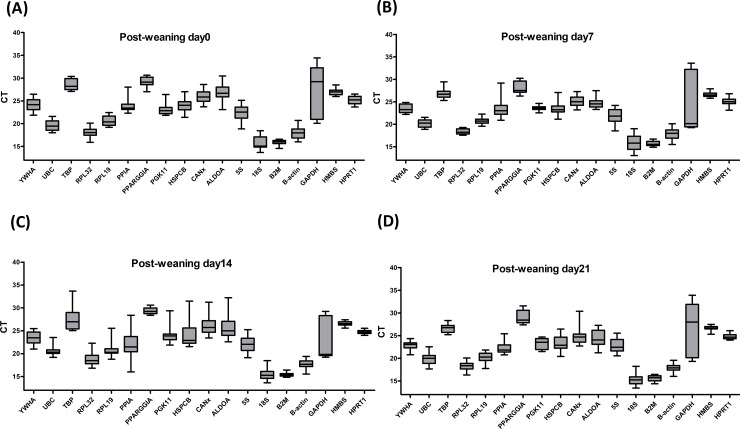
Distribution of the CT values of the reference genes at different growth stages of the gastrointestinal tract.The boxes encompass the 25th to the 75th percentiles. The middle line in a box marks the median. Whisker caps indicate the minimum and maximum values.